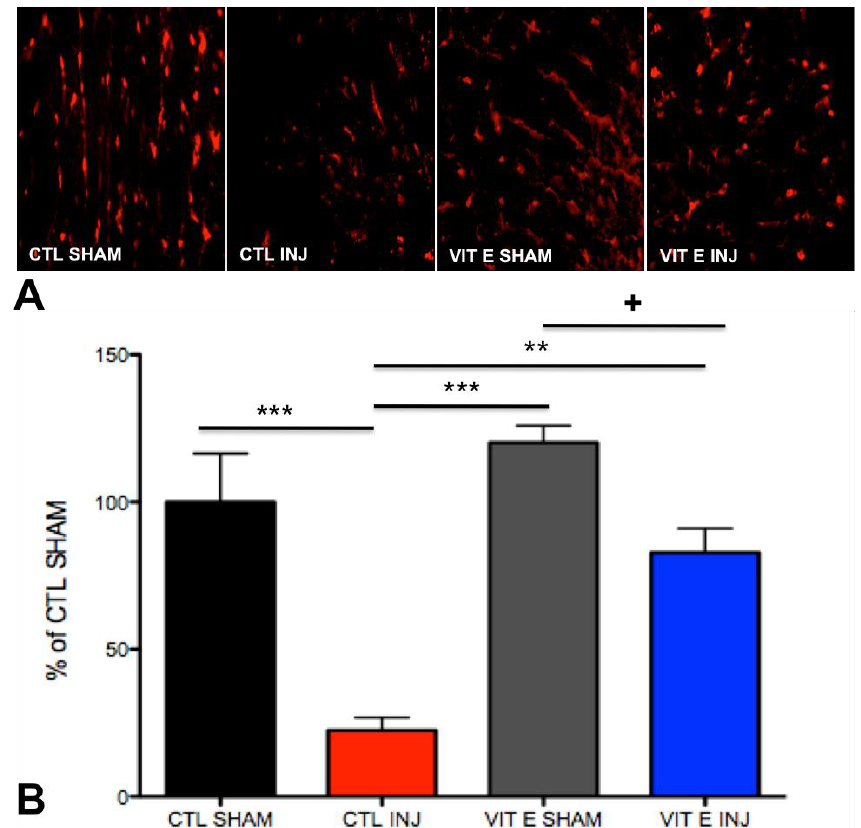
Figure 6. Vitamin E preserves oligodendrocytes at 1 week after spinal cord injury. ( A )Expression of oligodendrocyte markers was quantified in the white matter of the spinal cord. ( B ) Manual quantification of cell numbers and normalization to control shams revealed decreased numbers of APC+ in the white matter of injured control rats, but not in injured vitamin E fed rats. There was a statistically significant increase of APC+ cells in vitamin E fed rats compared to injured control rats. Bonferroni test analysis was carried out to determine the statistically significant differences between diets. There was a significant difference in APC positive cells between uninjured rats in the vitamin E-enriched diet and injured vitamin E-enriched diet when they were analyzed using an unpaired t -test (+ p = 0.0059). Error bars represent means ± standard error of the mean (*** p < 0.0001, CTL SHAM, n = 6 vs. CTL INJ, n = 6 and VIT E SHAM, n = 5 vs. CTL INJ, n = 6; p > 0.05 CTL SHAM, n = 6 vs. VIT